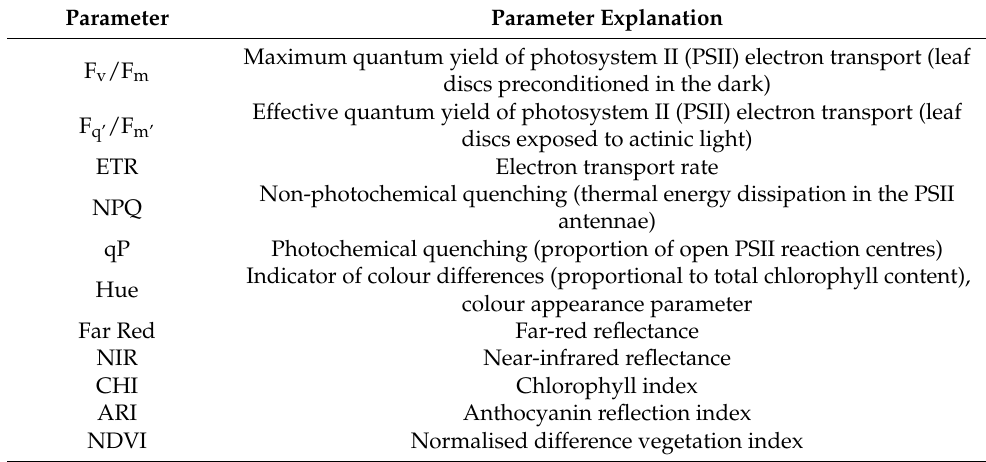
Table 4. Chlorophyll fluorescence and multispectral imaging